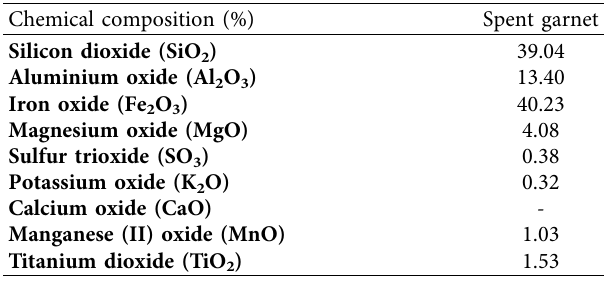
Table 3: Chemical composition of spent garnet.